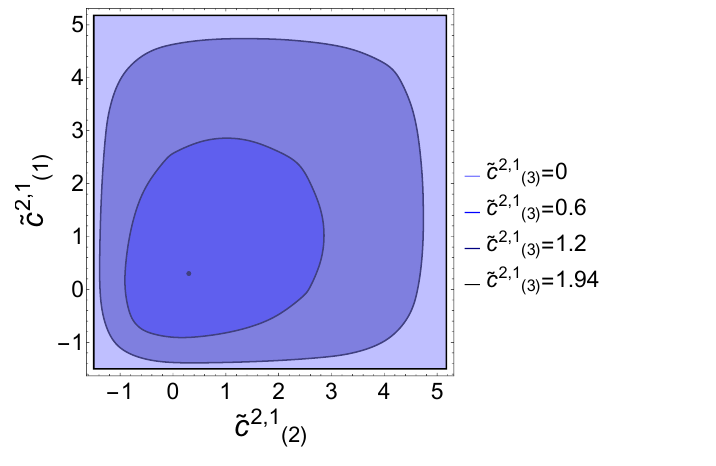
= ˜ c 2 , 1 = ˜ c 2 , 1 = 4˜ c 2 , 1 ) for Z symmetric bi-scalar , ˜ c 2 , 1 , ˜ c 2 , 1 2 1111 2222 1122 (1) (2) (3)